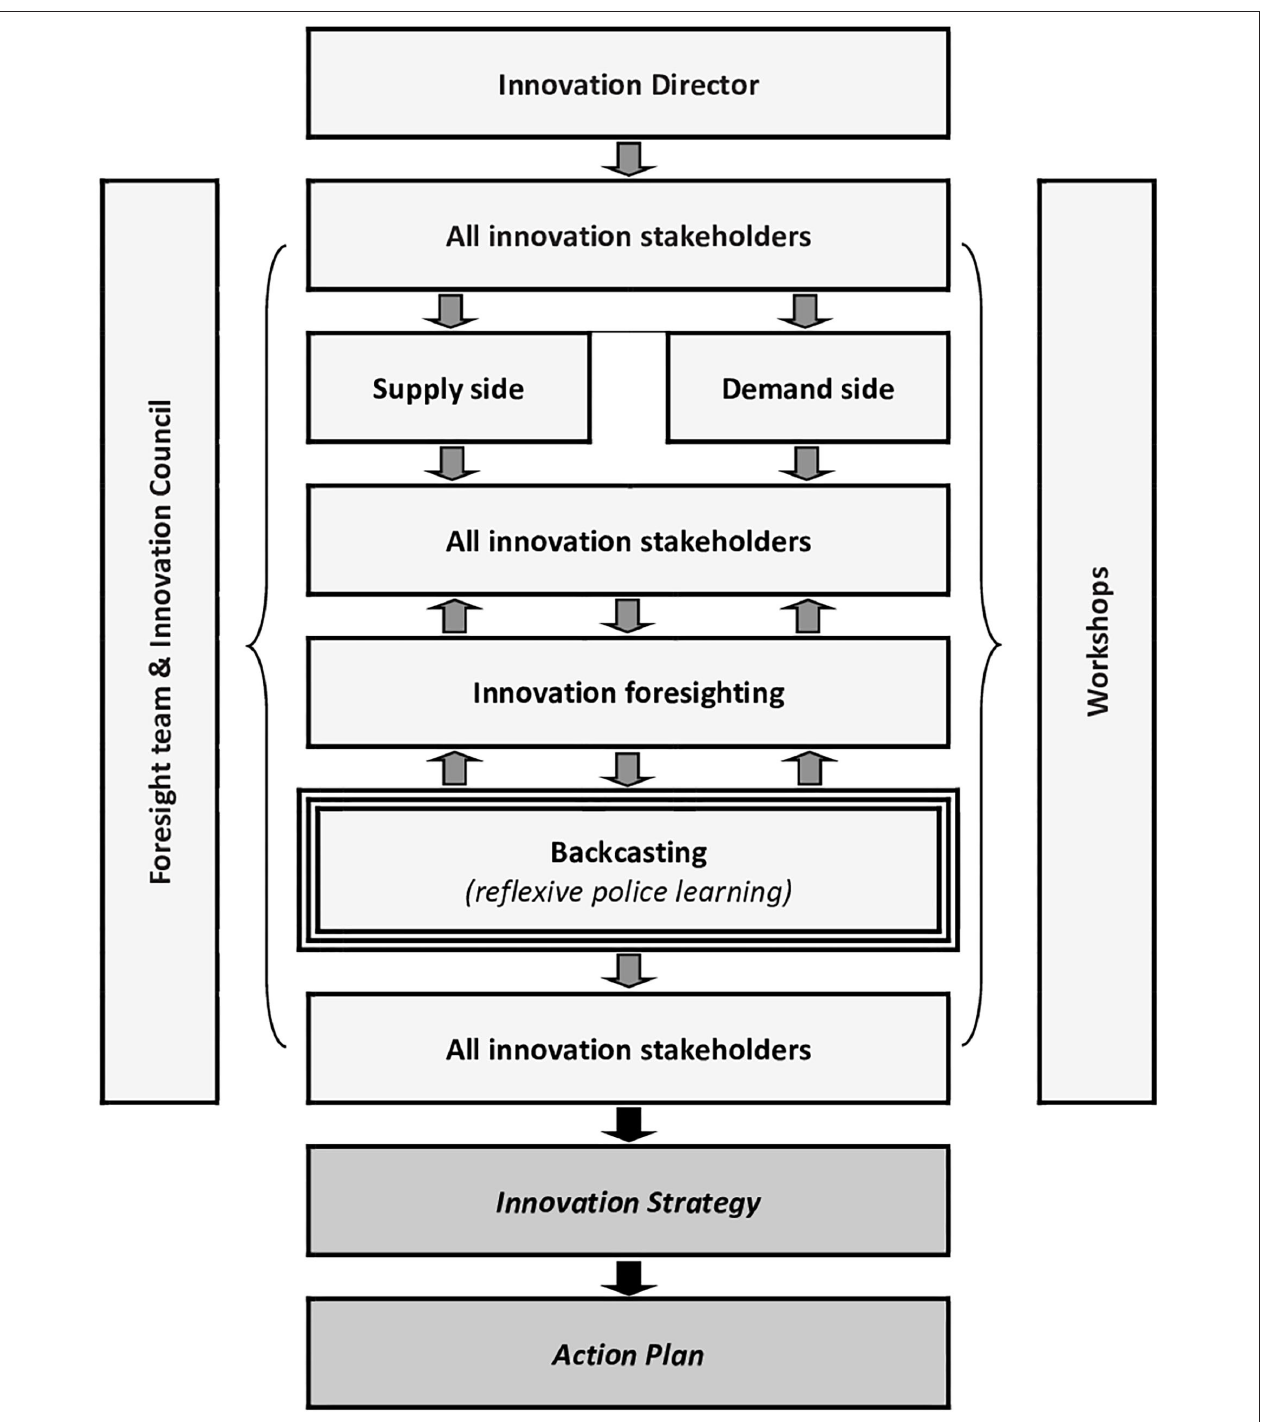
FIGURE 2 | Decision-making process with the participation of multiple stakeholder groups. Backcasting is crucial for inducing reflexive learning in the respective policy communities; adapted from Jezic von Gesseneck et al. (2018).